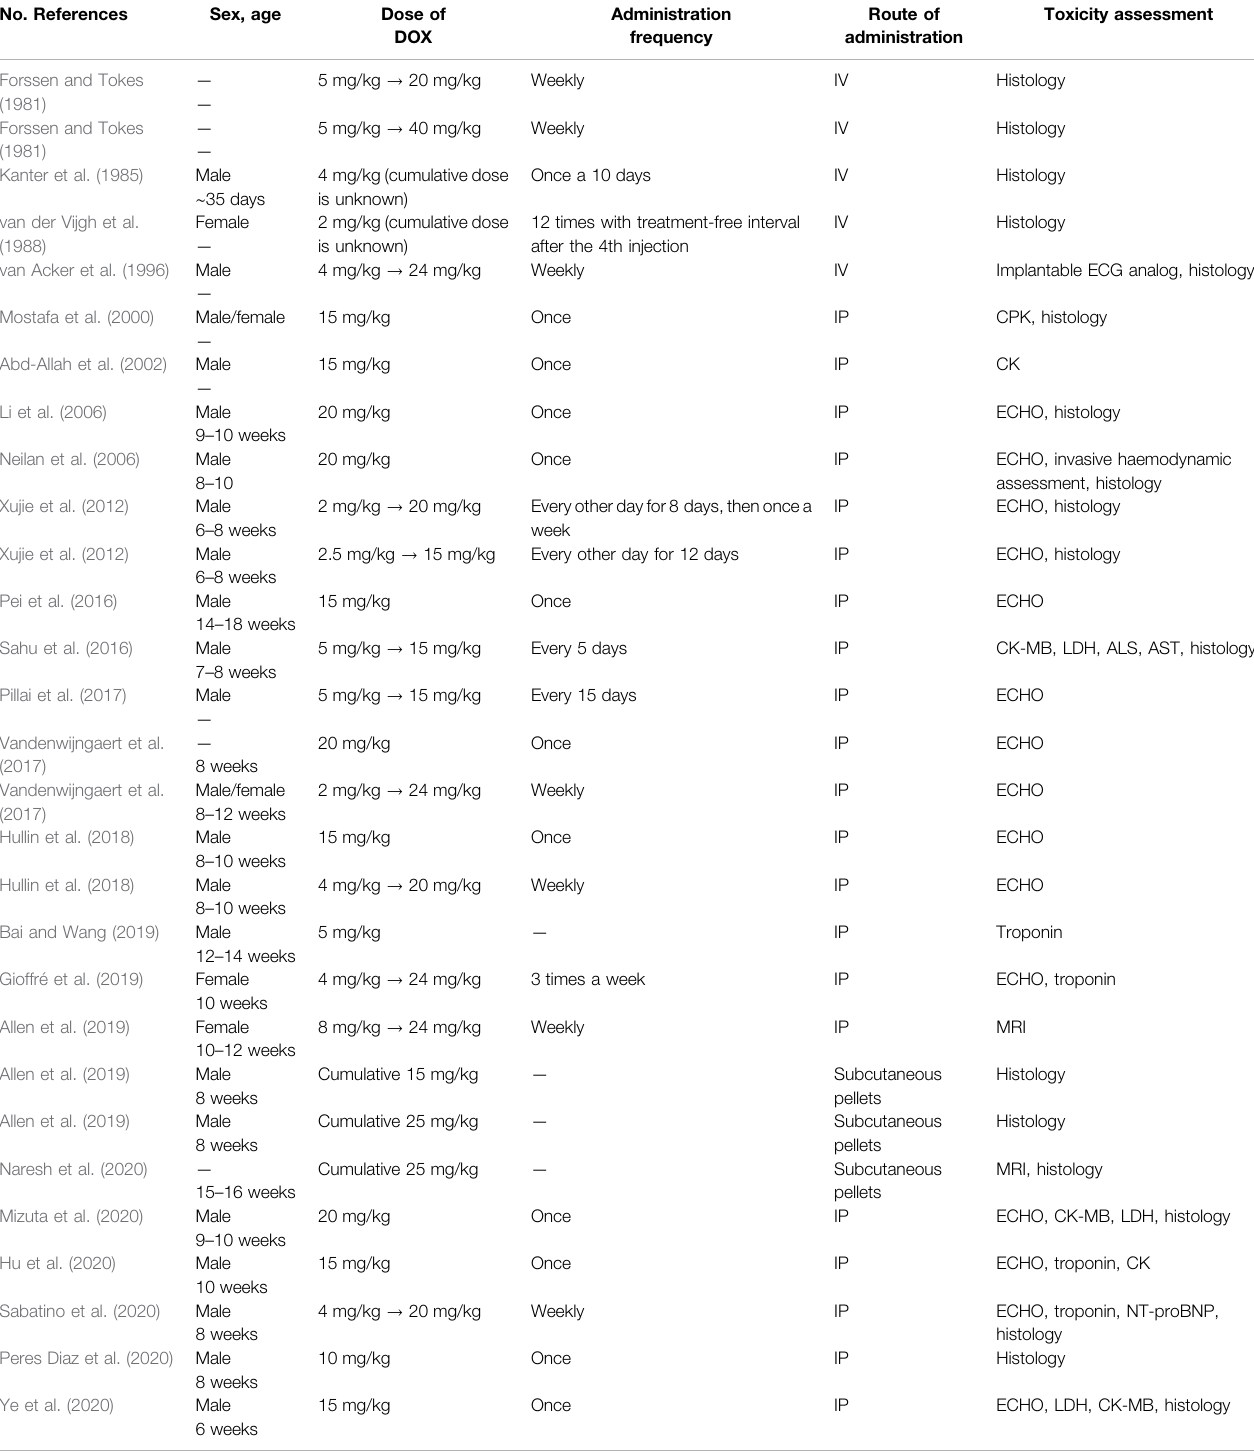
TABLE 2 | Data on the modeling of doxorubicin cardiomyopathy in